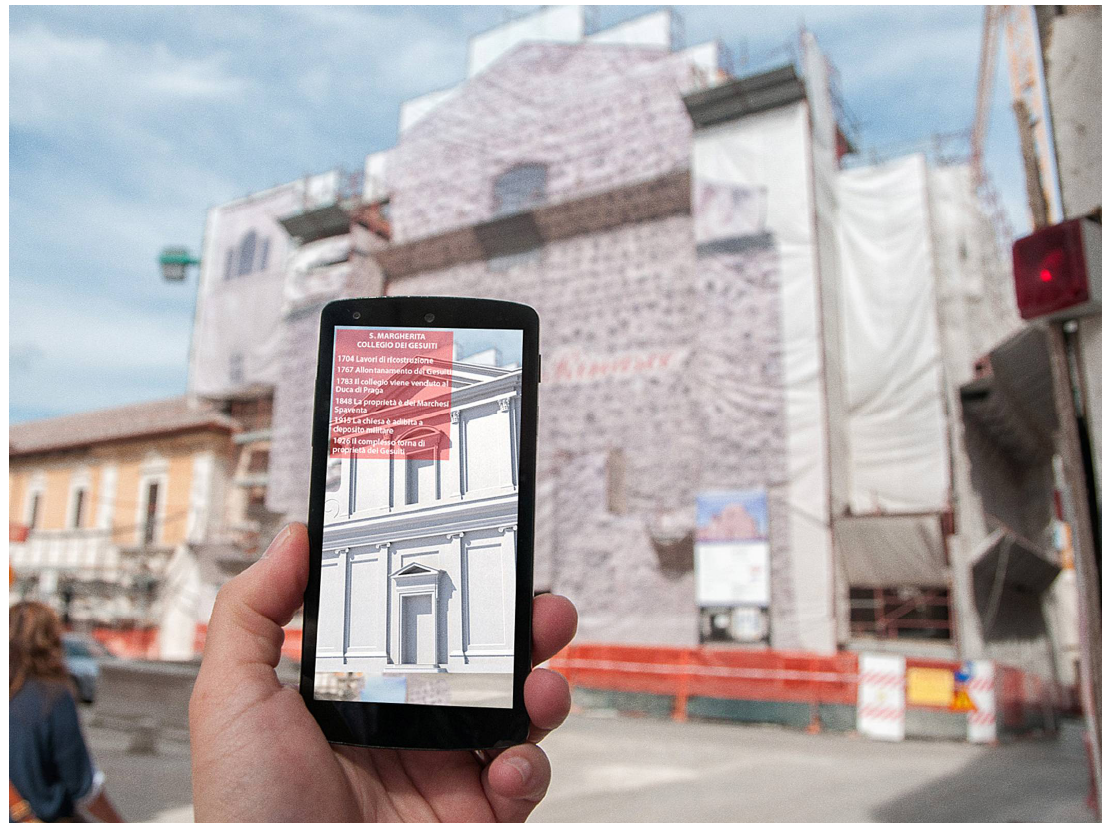
Figure 6. Application of Augmented Reality. The facade reconstruction, linked to a two-dimensional target, can be visualized in real time. It is also possible to make the visualization interactive by inserting sensitive areas that can show monument information, links to external resources, social sharing links, etc. The test app was created using Unity 3D and an augmented reality plugin named Vuforia